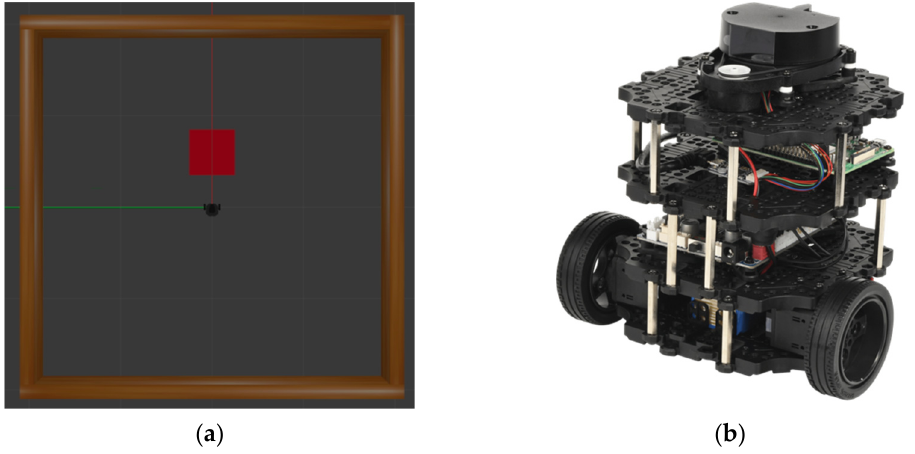
Figure 1. ( a ) Turtlebot3 in the simulation environment. The red square box is the destination, the red line is the x ‐ axis, and the green line is the y ‐ axis. and ( b ) a real T urtleBot3.